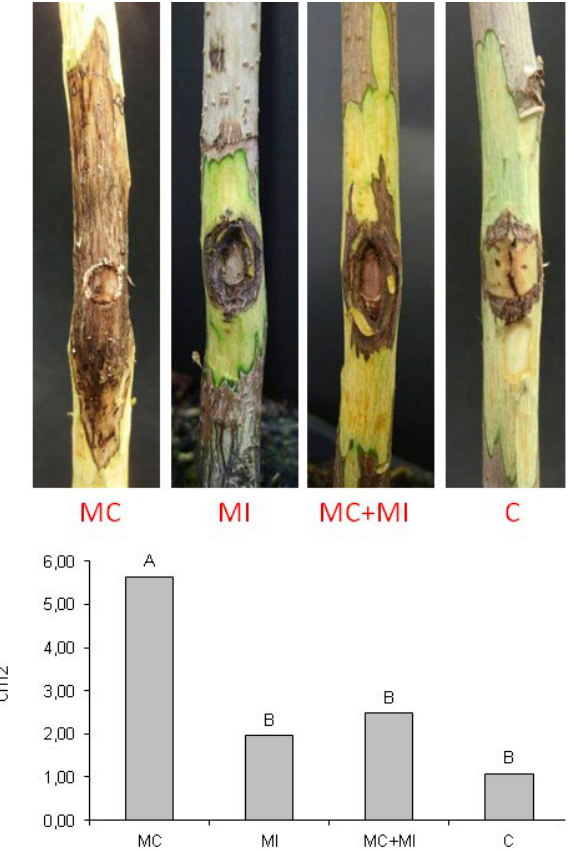
Figure 6. Pathogenicity and compatibility between Geo- smithia morbida monoconidials 100 d after inoculation. MC, compatible monoconidial; MI, incompatible monoconidi- al; MC+MI, both monoconidials vertically inoculated (two half-plugs); C, PDA controls. ANOVA, P < 0.05.